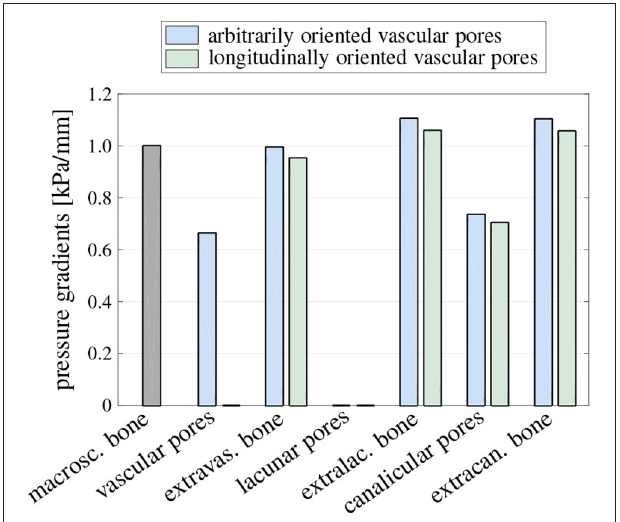
FIGURE 3 | Pressure gradient grad p macro [0,0,1] T kPa/mm applied on the = level of macroscopic bone tissue, and the corresponding maximum pressure gradients in all considered material phases, for both arbitrarily and longitudinally oriented vascular pores; in the cylindrical (vascular and canalicular) pore phases, the respective maximum pressure gradients in pore direction are shown, thereby considering all possible pore